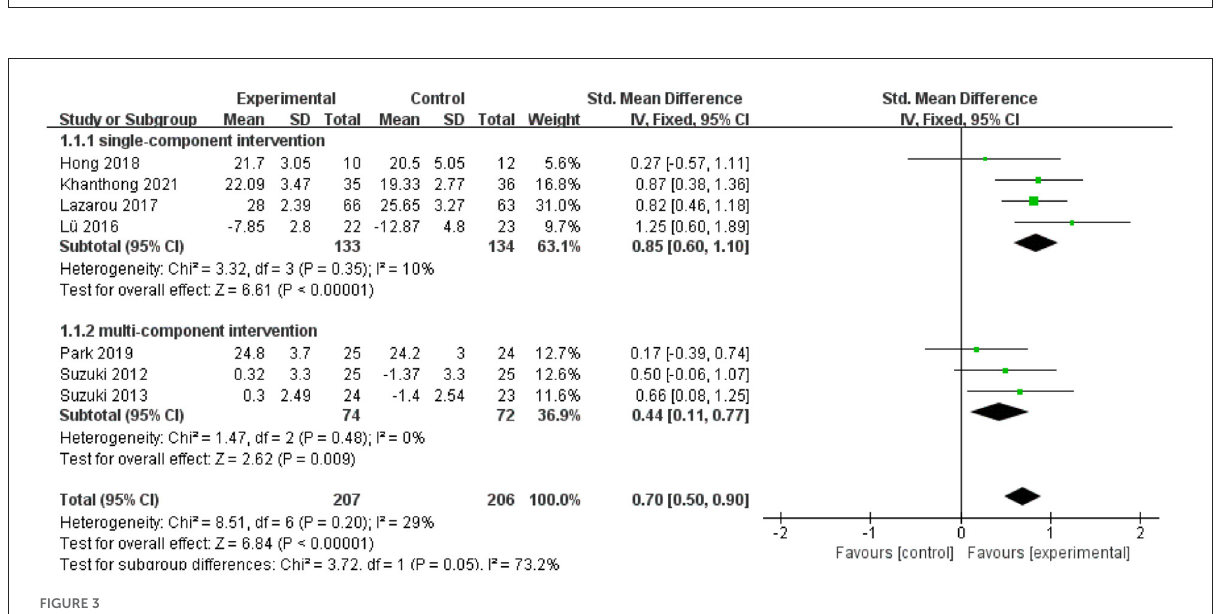
FIGURE2 Details of bias of the included studies.